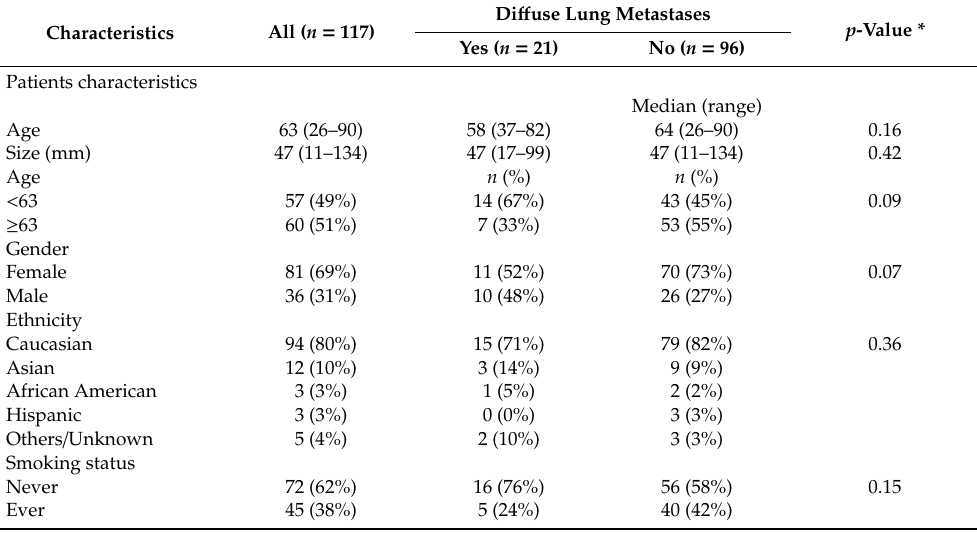
Table 2. Patients characteristics and imaging features, among EGFR -mutant patients ( n =